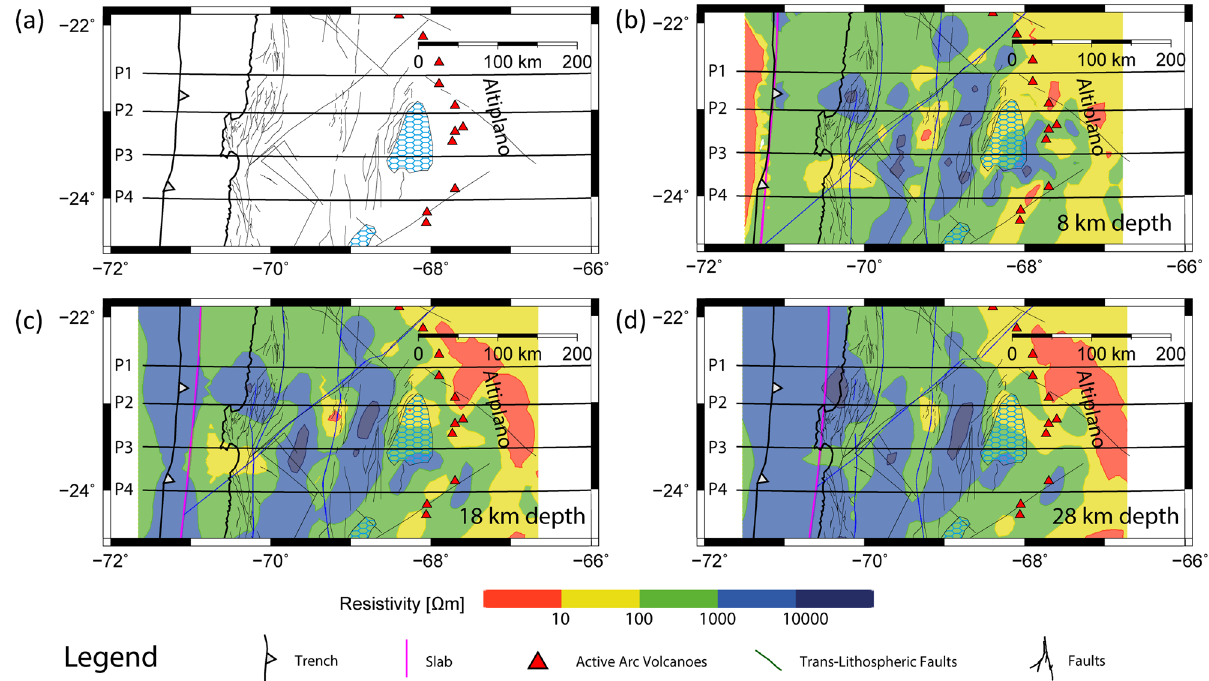
Figure 3. Plan map view for ( a ) major structures in northern Chile between 22°S and 24.5°S from Santibañez et al. 38 . ( b ), ( c ) and ( d ) show the electrical resistivity models 37 in map view at z = 8, 18 and 28 km depth, respectively. The electrical resistivity model is reliable for depths up to 100 km 37 . However, at some regions, there are highly conductive bodies in the upper crust, such as the Salar de Atacama basin, which significantly decreased the penetration depth. Therefore, we show slices for depths shallower than 30 km depth, where the electrical resistivities found in the complete study area ( a ) are reliable according to sensitivity tests (see Supplementary Information). See also Slezak et al. 37 for more information regarding the electrical resistivity model, including details of the starting model, the grid size/parametrization, the co-variance parameter chosen, error floors employed, the number of iterations, and the final model RMS misfit. We use the GMT version 5.0 (https:// www. gener ic- mappi ng- tools. org) and Leapfrog Geo version 5.0.1 (https:// www. seequ ent. com) softwares for generating this